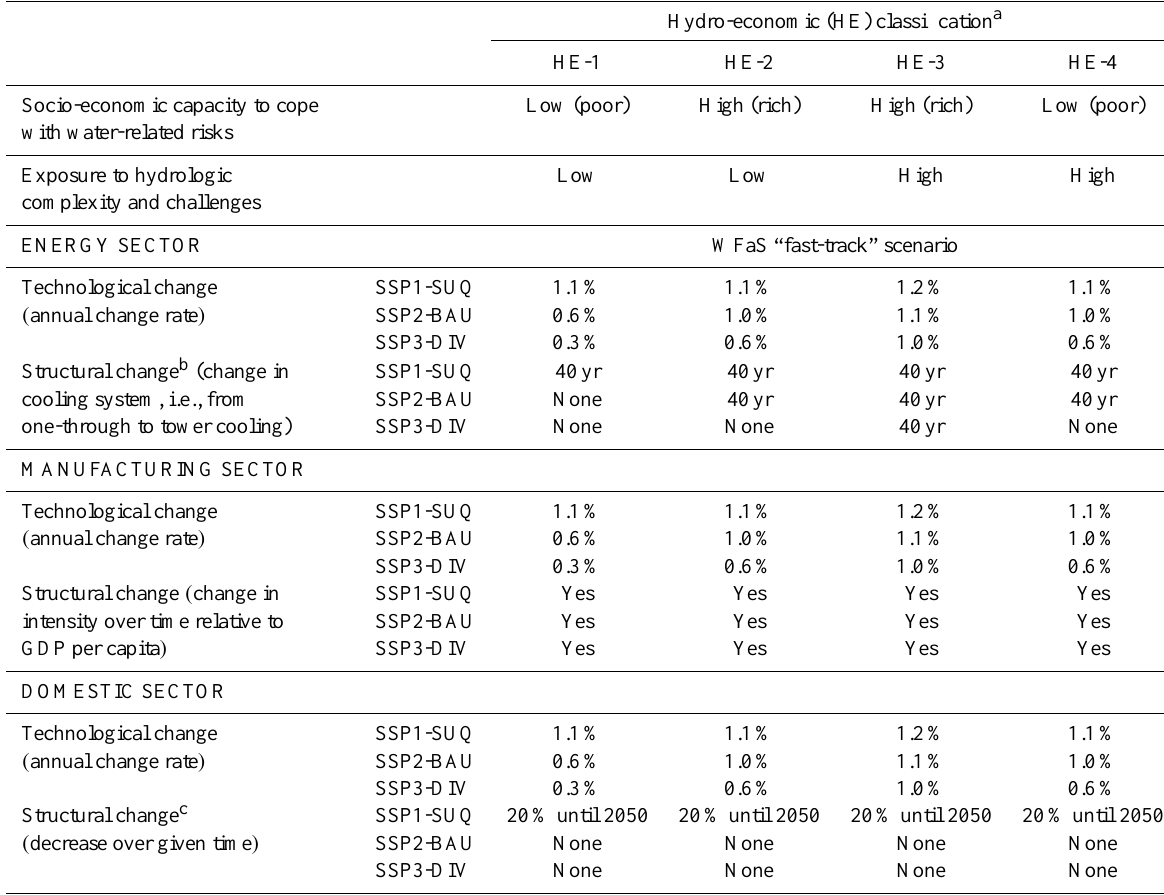
Table 5. Scenario assumptions for technology and structural change in the industry and domestic